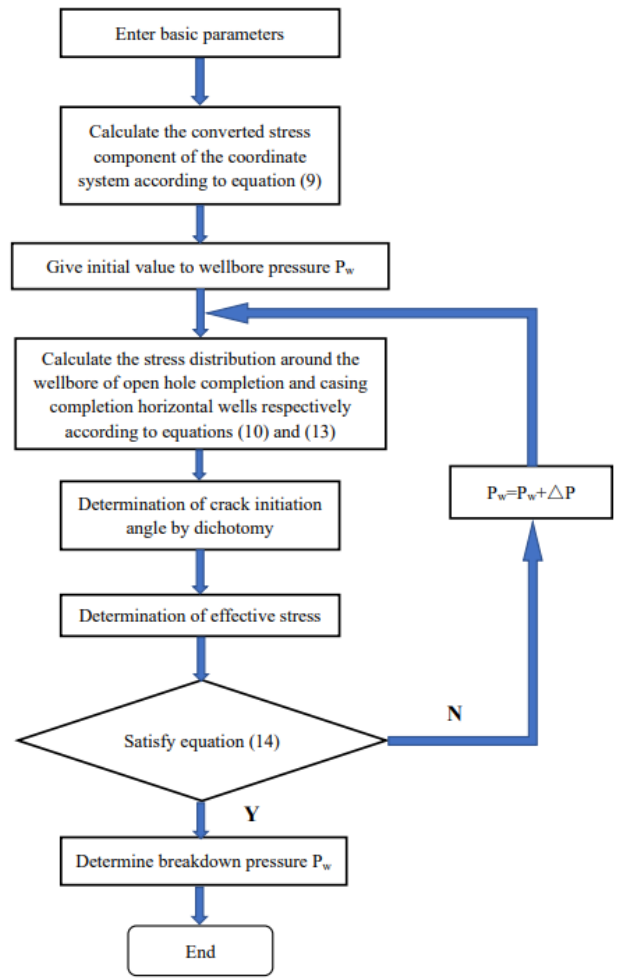
Figure 3. Flow chart of fracture calculation based on the horizontal well stress field model.